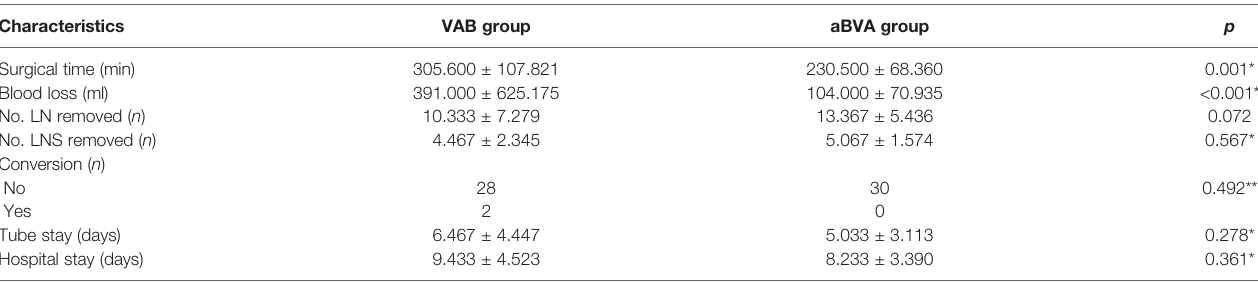
TABLE 2 | Differences in surgical outcomes between the VAB and aBVA groups.